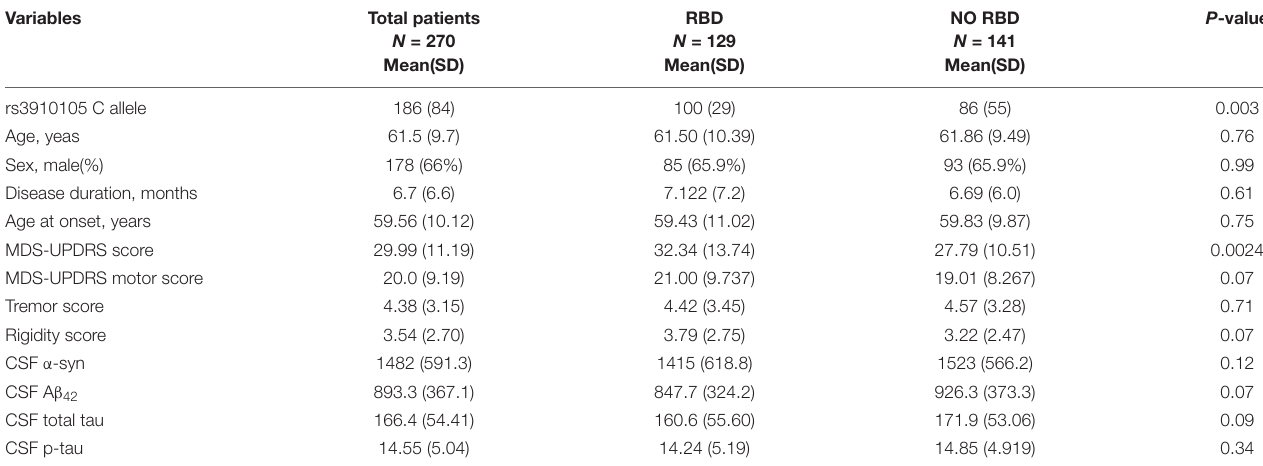
TABLE 2 | Baseline characteristics of PD patients who later developed RBD or without RBD during.